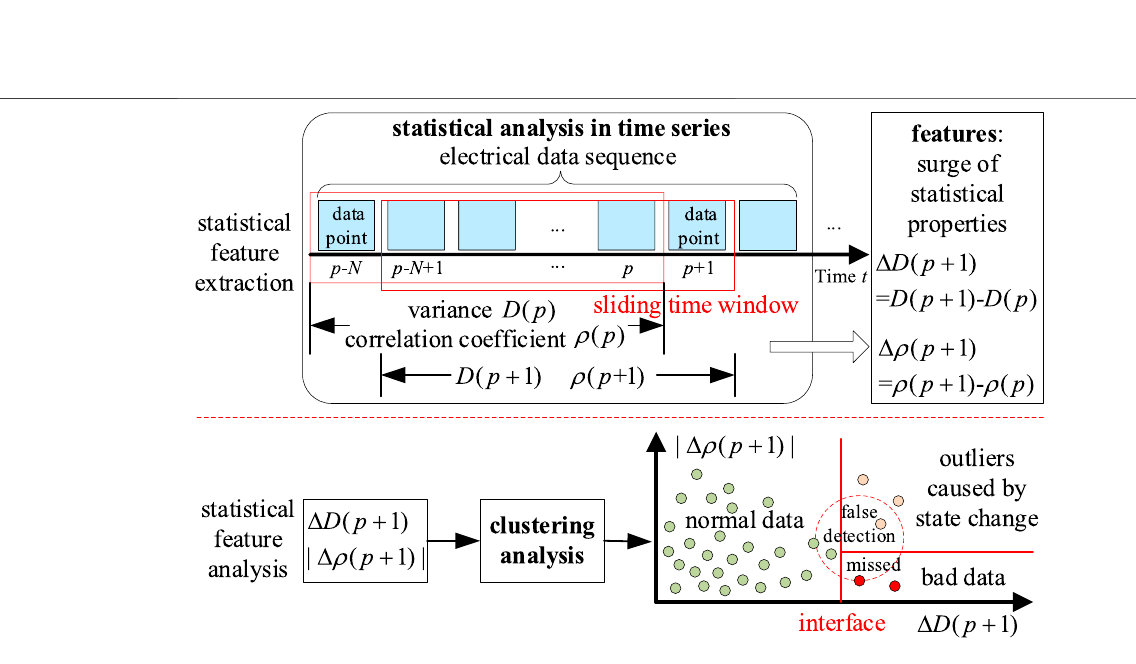
FIGURE 5 | Bad data detection based on statistical analysis in time